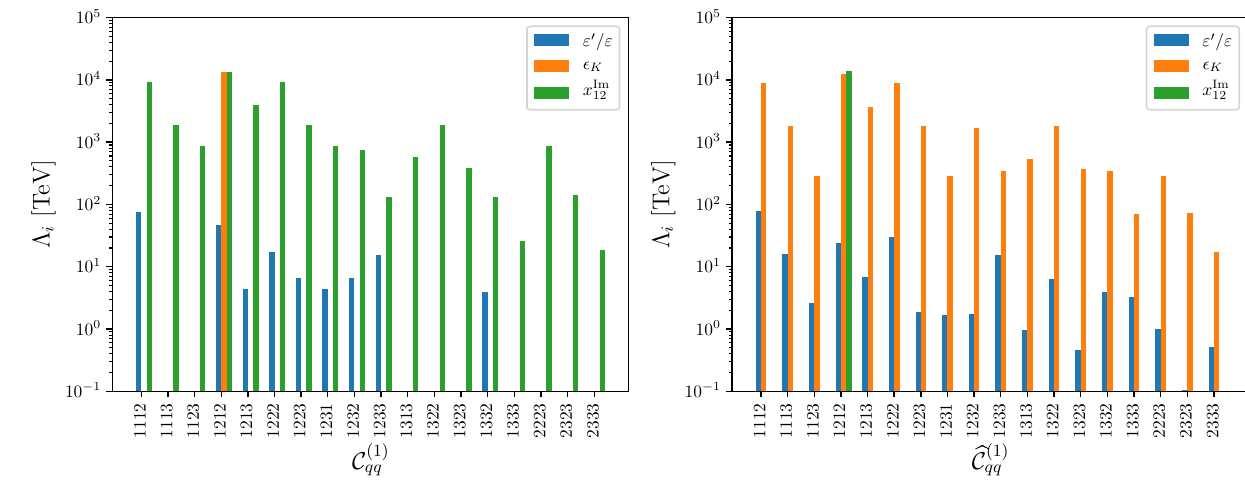
type quark mass matrix is diagonal. Only non-redundant flavour-index combinations are shown. Coefficients that do not generate a visible effect in either observable have been omitted. The scales corresponding ( 3 ) to C qq are not shown but are very